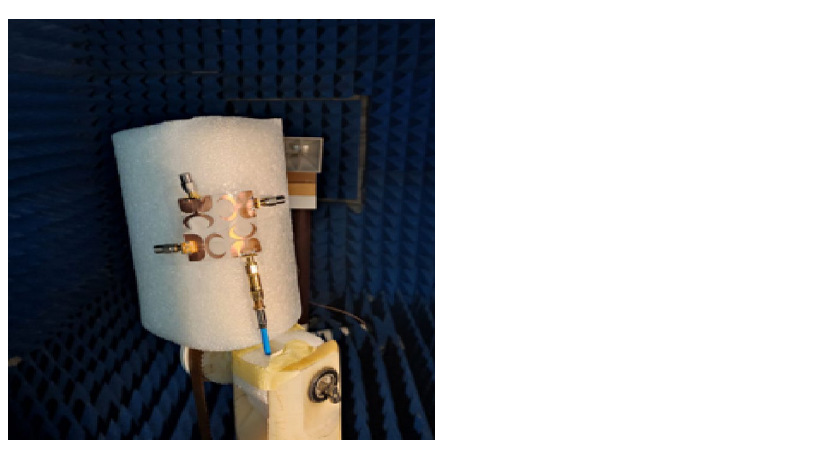
Figure 17. Radiation patterns testing setup of the flexible MIMO antenna in bending configuration with R = 45 mm inside the anechoic chamber.